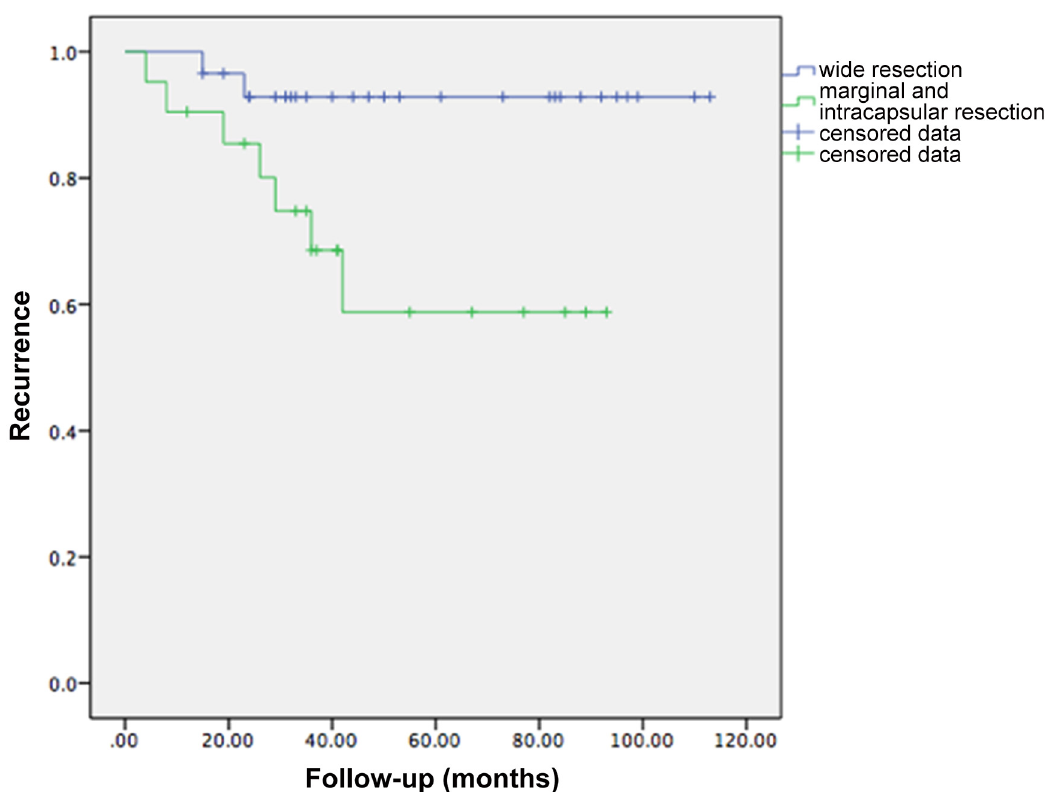
Fig 2. A Kaplan-Meier survival curve showing significant difference between recurrence rates of tumors with wide surgical margin and those with marginal or intracapsular margins (p = 0.02).